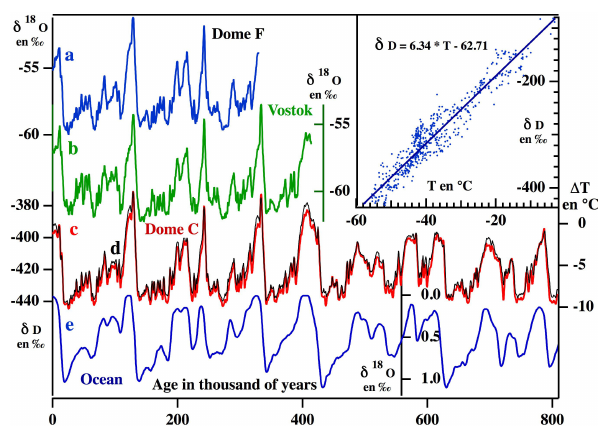
Fig. 6. Stable isotope records from deep Antarctic ice cores: Dome F (Watanabe et al., 2003), Vostok (Petit et al., 1999) and Dome C (Jouzel et al., 2007a), in addition to the Dome C tempera- ture (red curve, temperature scale on the right) estimated using the conventional approach (based on the use of the spatial slope, see insert adapted from Masson-Delmotte et al., 2008) as a surrogate of the temporal slope. The oceanic record adapted from Lisiecki and Raymo (2005) is used as a proxy of sea-level